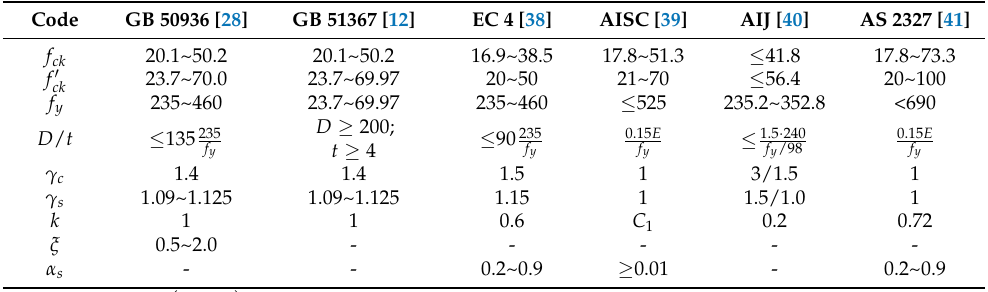
Table 5. Detailing requirements of relevant